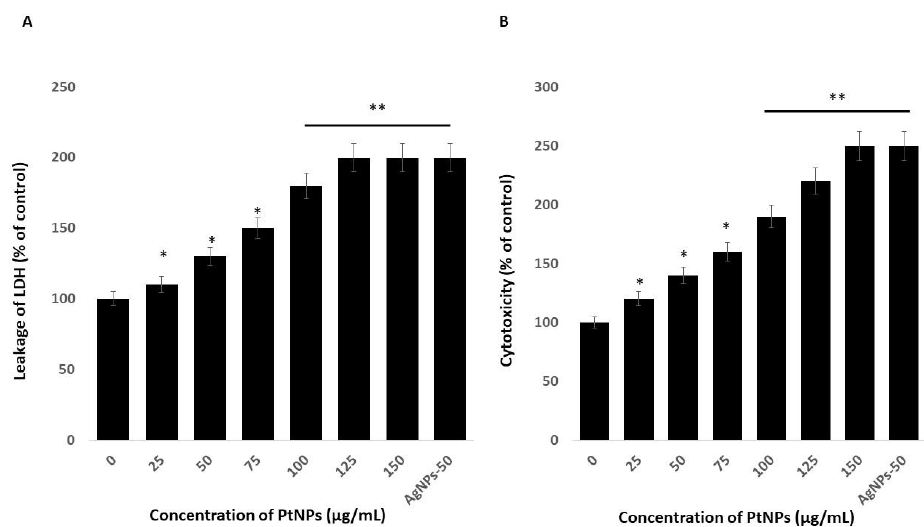
Figure 4. PtNPs increase the leakage of lactate dehydrogenase (LDH) and intracellular protease. ( A ) THP-1 cells were treated with PtNPs (25–150 µ g / mL) for 24 h, and LDH activity was measured at 490 nm using the LDH cytotoxicity kit. ( B ) Intracellular protease activity was determined by assessing the association of intracellular proteases with a luminogenic peptide substrate (alanyl-alanylphenylalanyl-aminoluciferin) after 24 h of exposure to PtNPs (25–150 µ g / mL). Cell death was quantified as the ratio of living cells. At least three independent experiments were performed for each sample. Results are expressed as mean fold change ± standard deviation from three independent experiments. The treated groups showed statistically significant di ff erences from the control group by the Student’s t -test (* p < 0.05; ** p < 0.01). * significant; ** highly significant.